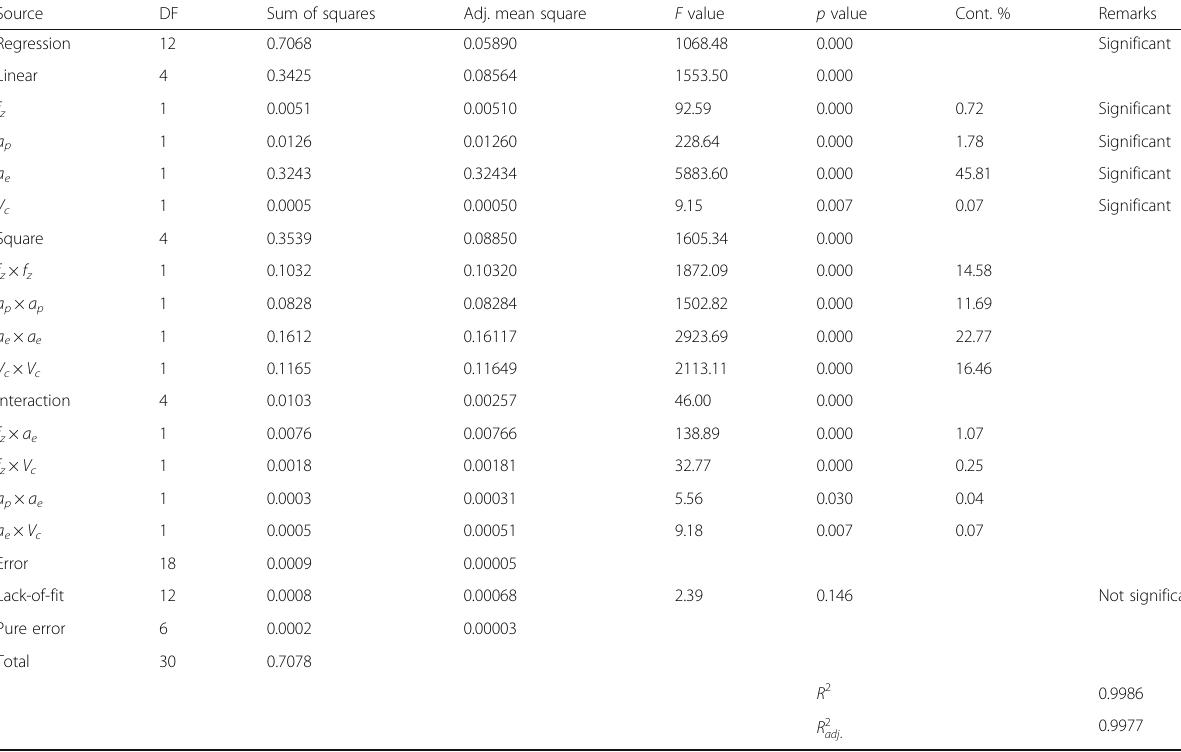
Table 4 Analysis of variance for mean roughness depth R a (µm) (reduced quadratic model) Source DF Sum of squares Adj. mean square